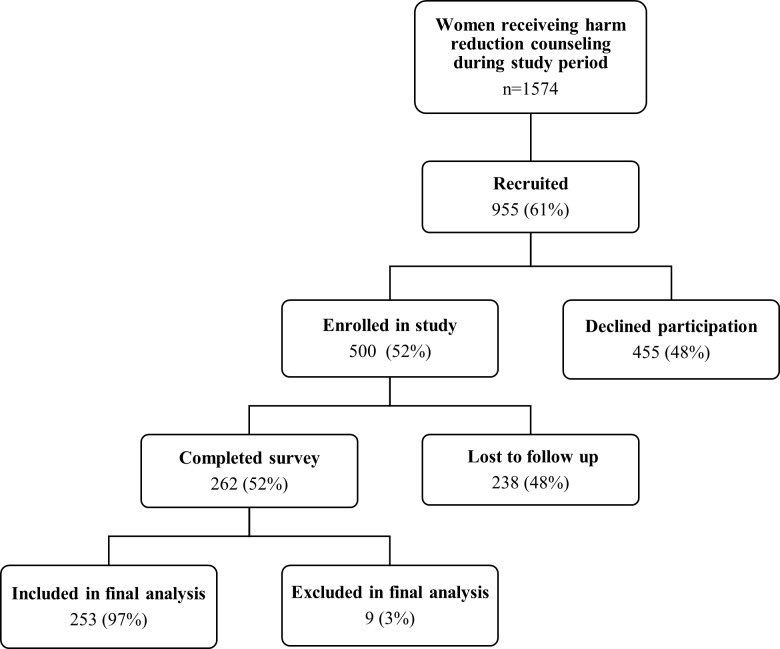
Study sample.The figure shows the flow of patients through the study.